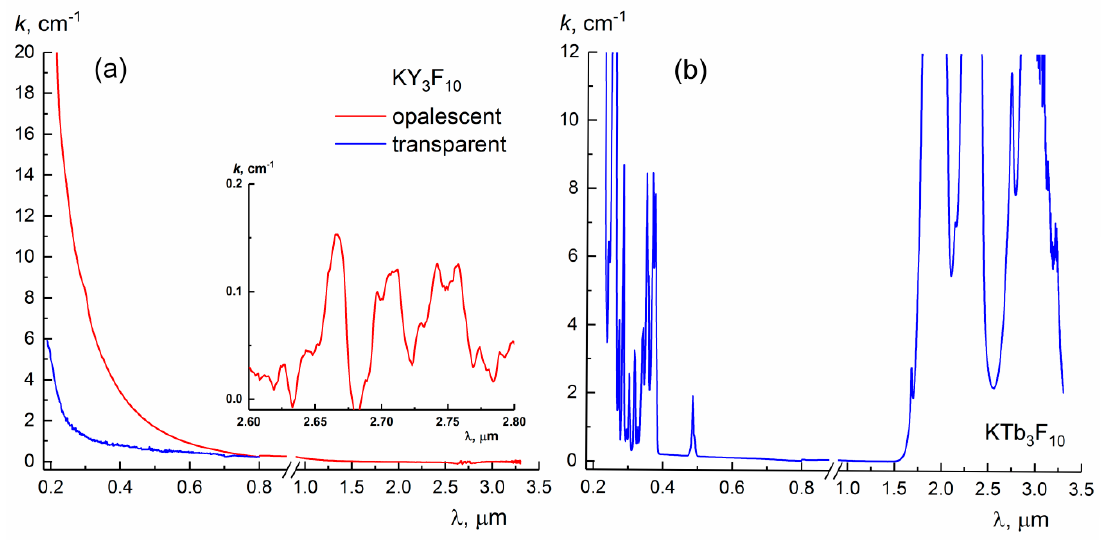
Figure 8. Absorption spectra of the transparent and opalescent samples of KY 3 F 10 ( a ) and KTb 3 F 10 single crystals ( b ). Insert: enlarged part of spectrum for KYF crystal in infrared region.